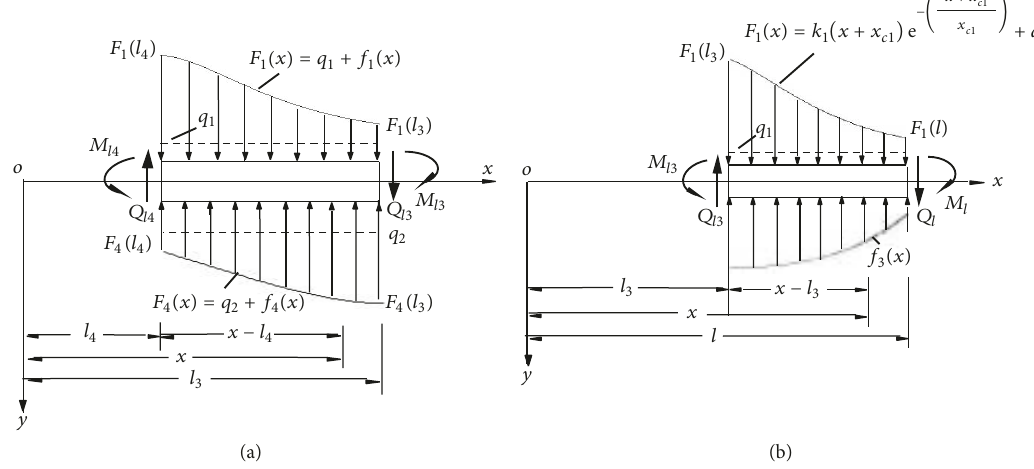
Figure 8: Charts of isolating body of the rock beam before first